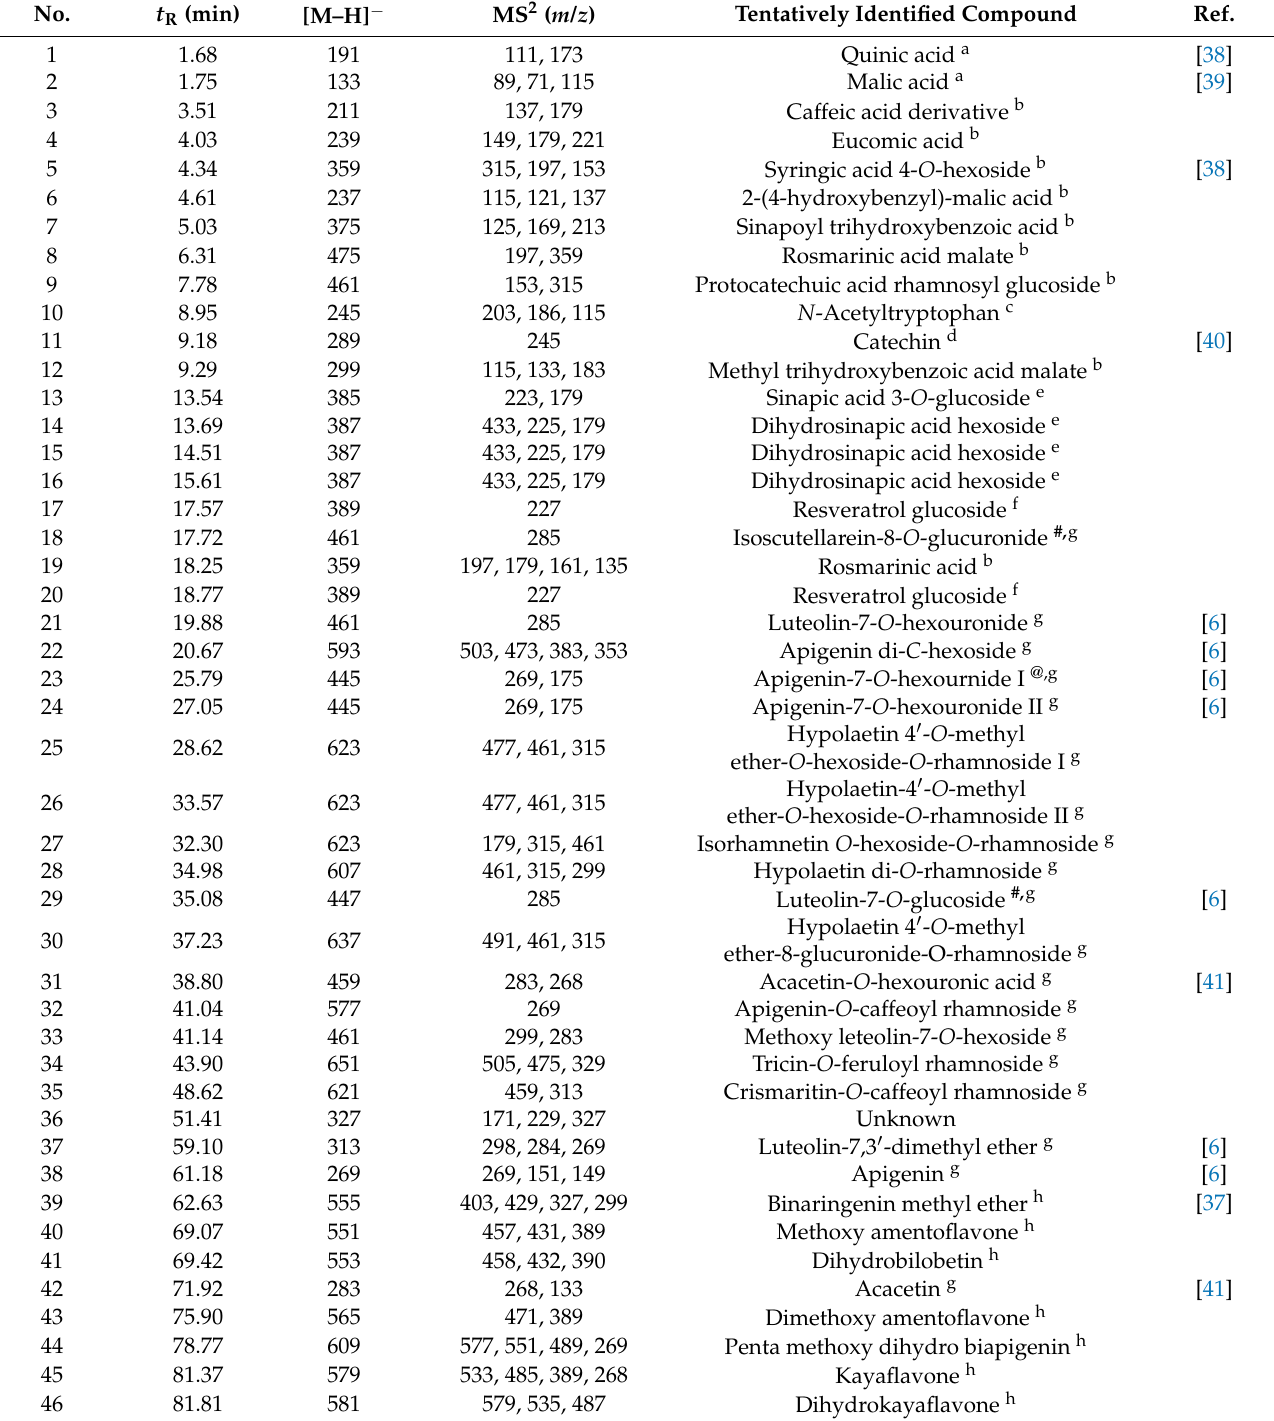
Table 1. Chemical composition of L. coronopifolia Poir. aerial parts’ extract using LC-MS/MS.